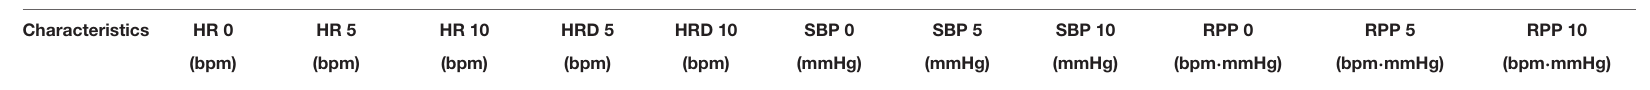
Good prognosis ( n = 40)